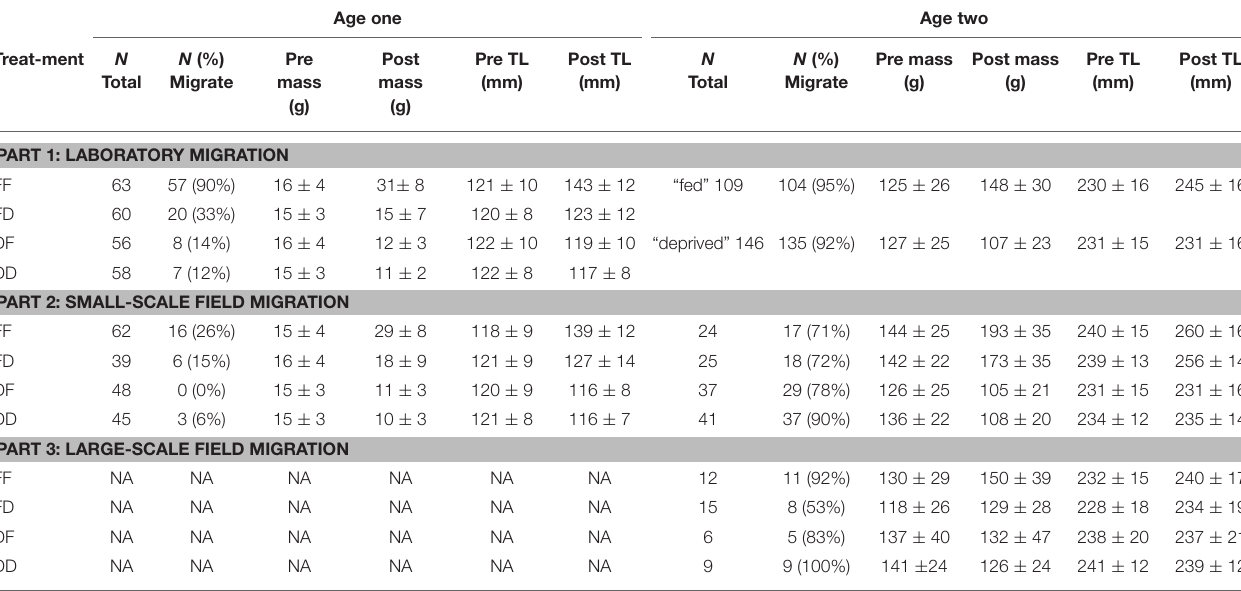
TABLE 2 | Total number of fish used, mean ± (s.d.) pre- and post-treatment mass, mean ± (s.d.) pre- and post-treatment total length (TL), and number and percentage of fish that were classified as migrating during each part of this